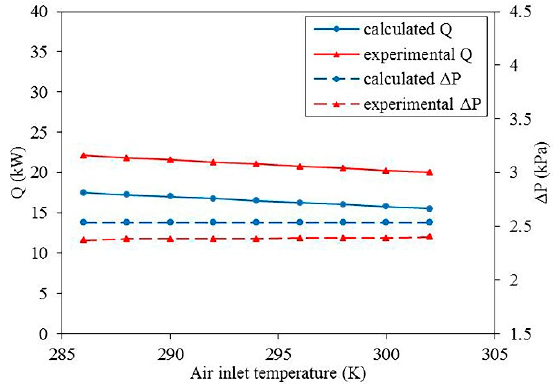
Figure 12. Comparison between calculation results and experimental data.